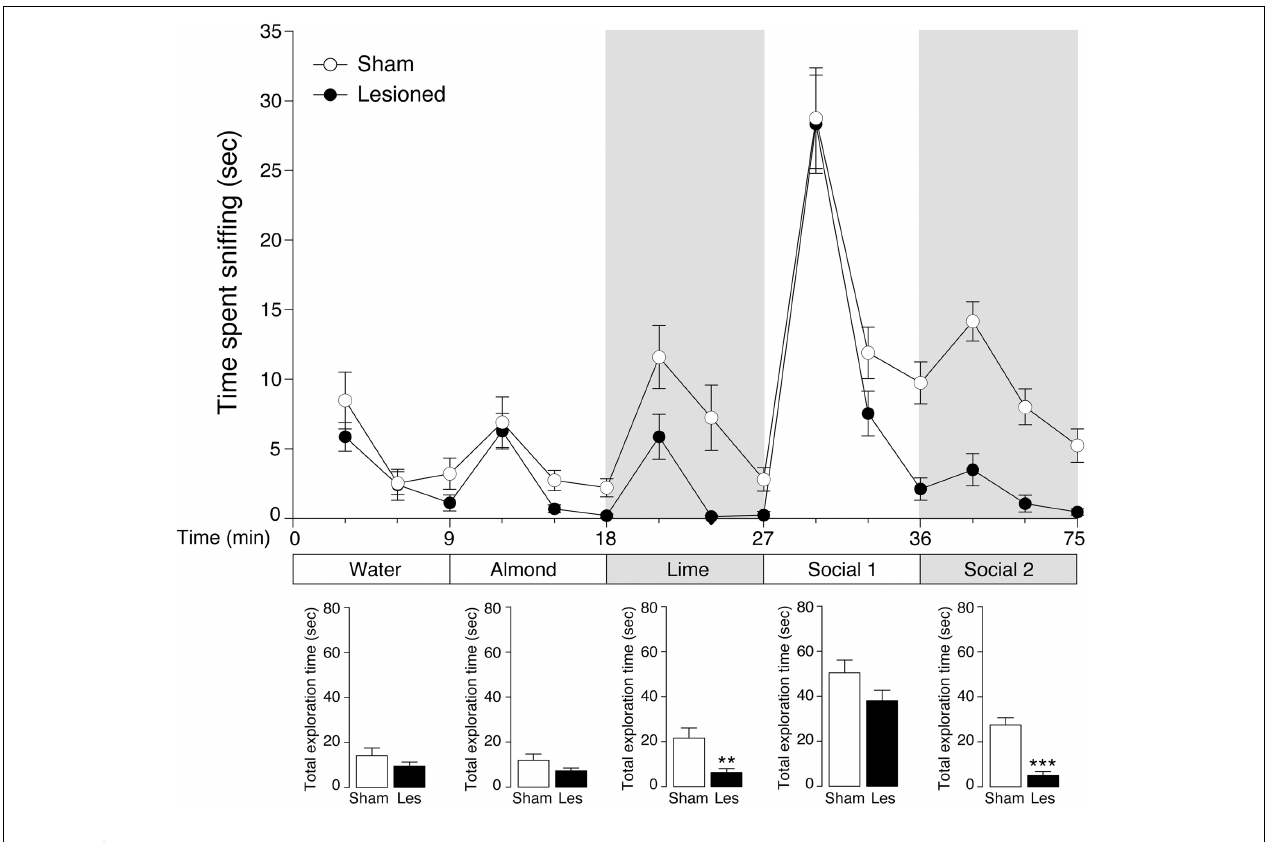
non-social (almond, lime) and social ( social 1 and social 2 ), with 30s intervals between each exposure. Lower panels show the total exploration time (s) spent by sham and 6-OHDA-lesioned mice sniffing individual odors (water, almond, lime, social 1 , social 2 ). The gray background indicates the second odor presented for each category (non-social and social). Data are presented as mean ±